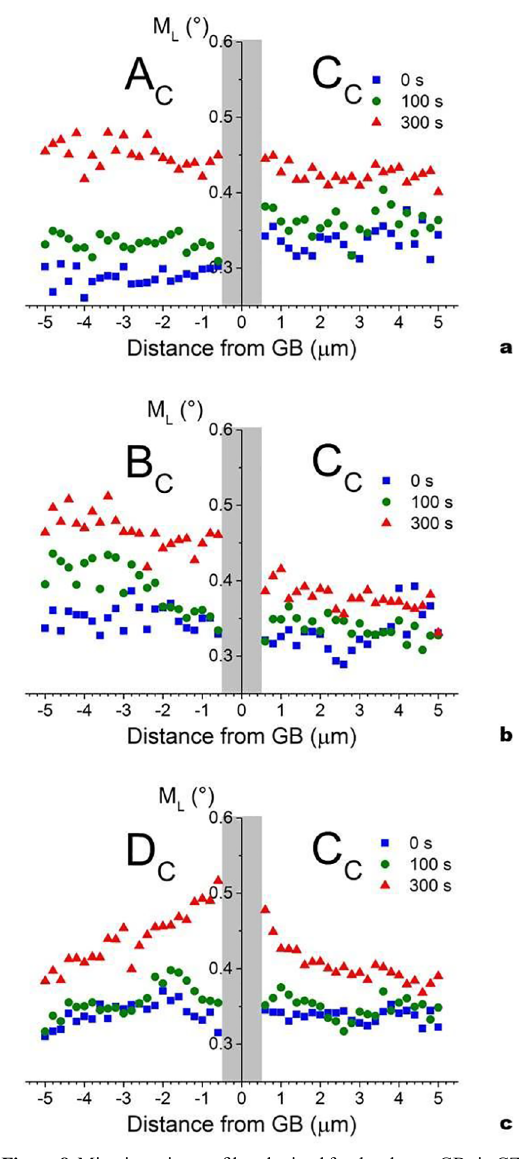
Figure 8. Misorientation profiles obtained for the chosen GBs in CZ. Figure 9. Misorientation profiles obtained for particular GBs in